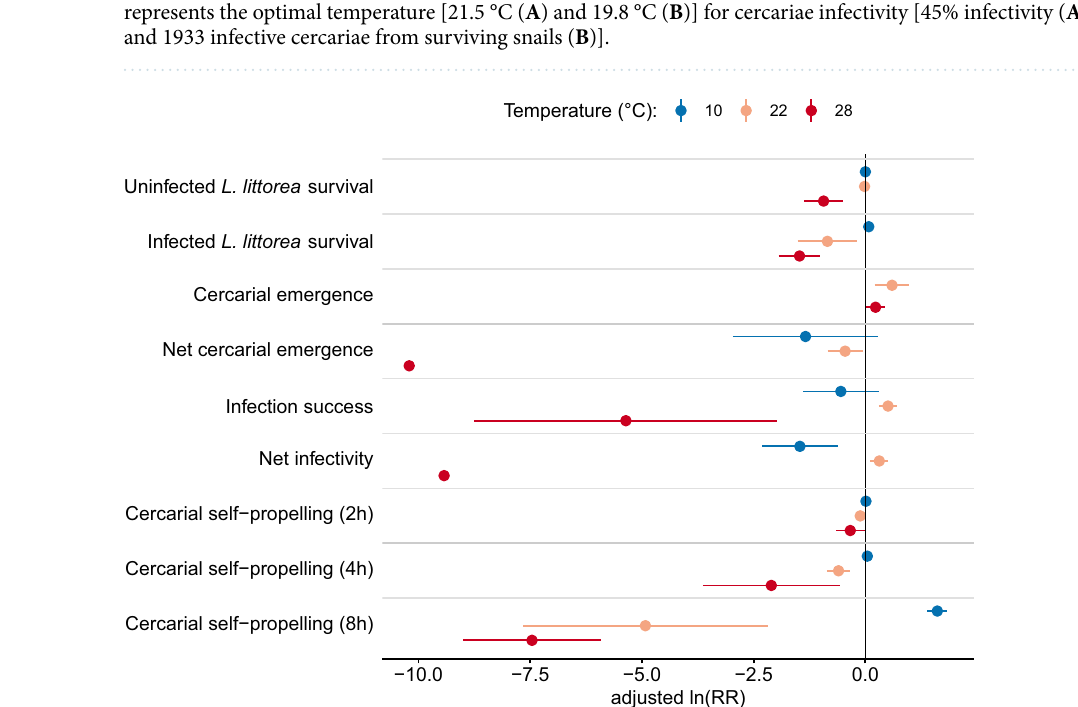
Figure 6. Logarithmic response ratios for crucial traits of the Himasthla elongata life cycle in response to temperature deviations. Ratios were calculated and adjusted to small sample sizes according to Lajeunesse 35 in relation to the baseline temperature of 16 °C. The means of the control temperature for each trait were estimated from the models described in the methods section. Values are given as means and confidence intervals (α =